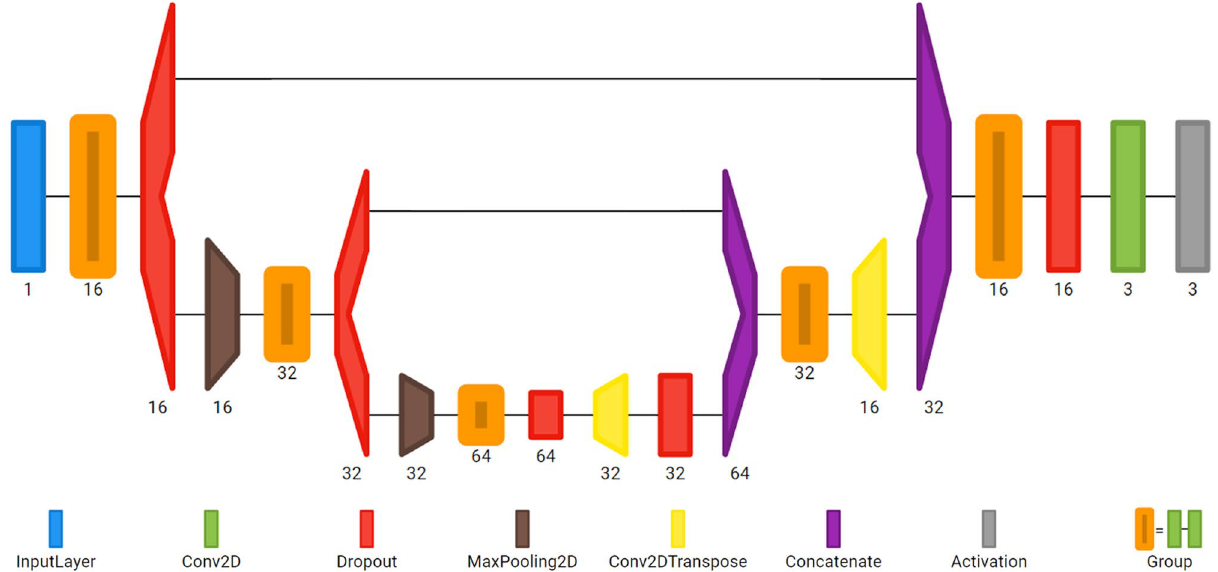
Figure 6. Architecture of proposed encoder-decoder convolutional neural network. It takes an image of 384 × 384 pixels resolution and process it in several convolutional, pooling, transposed convolutional and concatenation layers, before the final pixelwise semantic segmentation is performed with the “softmax” activation in the last classification